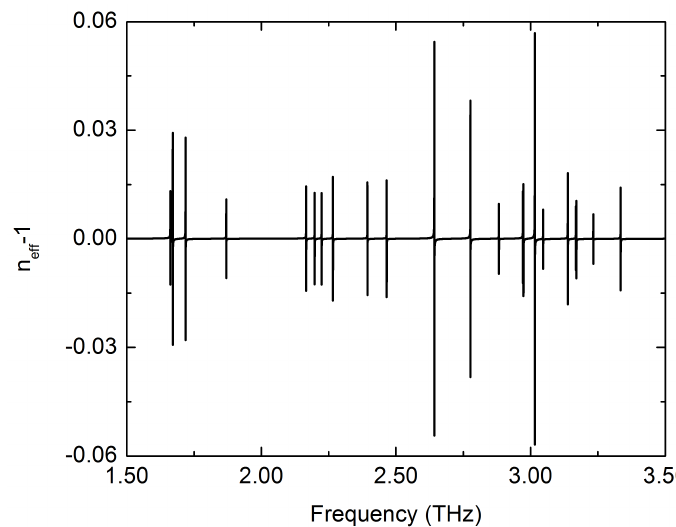
Figure 5. Refractive index of water vapor at 10 mbar and 10 − 6 mol [16]. The individual water absorption lines lead to a strong